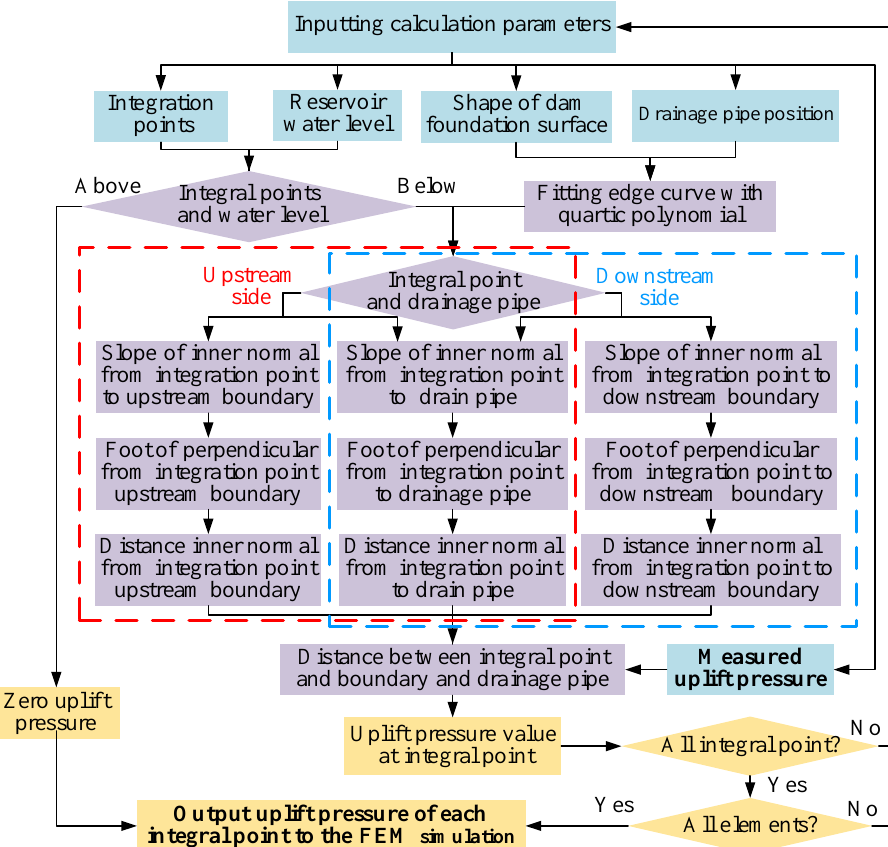
Figure 3. Flow chart of the application method of measured uplift pressure.